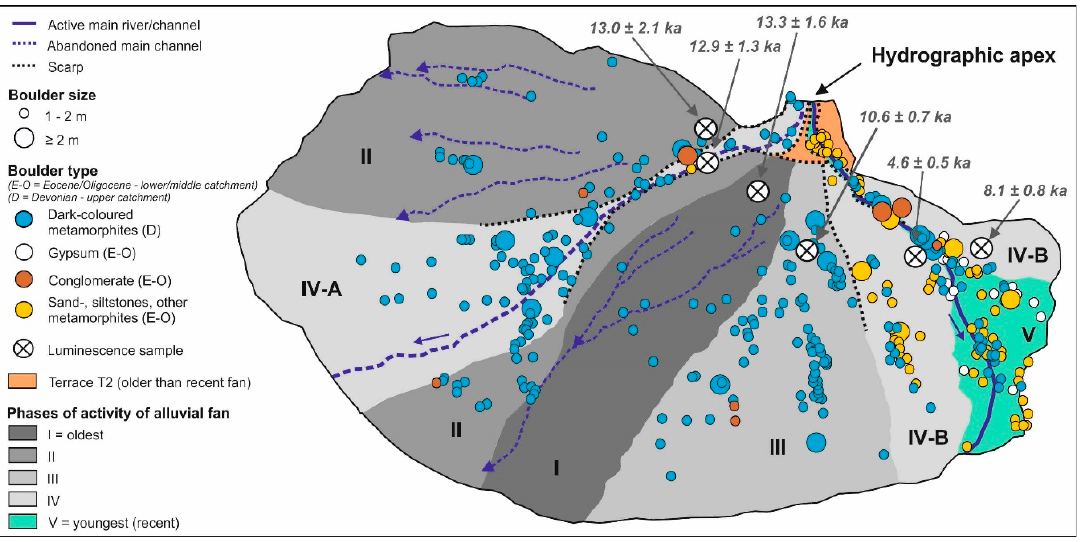
Figure 6. Geomorphological map of the present-day alluvial fan with the different fan generations I–V, luminescence ages and the distribution of boulders >1m according to size and lithology (location in the river system please see Figure 3). Table 3. Area, and number and properties of boulders on the surfaces of the different generations of the present-day alluvial fan.